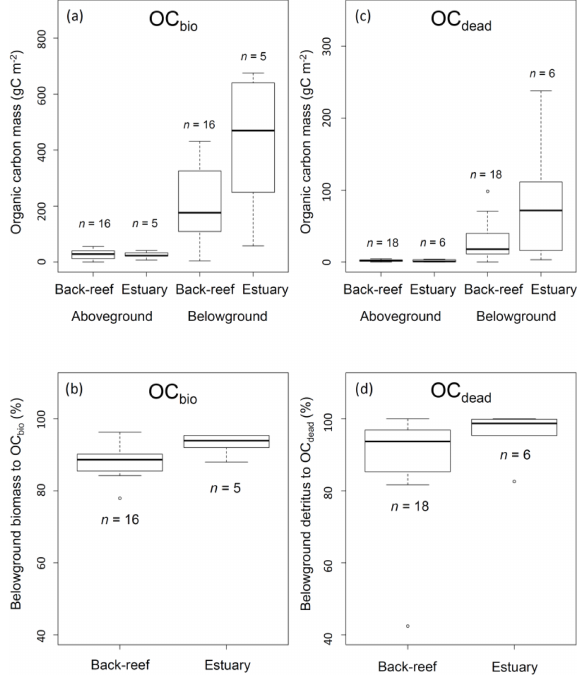
Figure 5. (a) OC bio (sum of aboveground and belowground biomass) (gCm − 2 ) ; (b) contribution of belowground biomass to OC bio (%); (c) OC dead (sum of aboveground and belowground detritus (gCm − 2 ) ; and (d) contribution of belowground detritus to OC dead (%). Boxes show the 25 and 75% quantiles; horizon- tal bands inside the box are median values; whiskers show maxi- mum and minimum values; and open circles show outliers. (a) and (b) show the data of vegetated sampling points and (c) and (d) show the data of vegetated and bare sampling points.